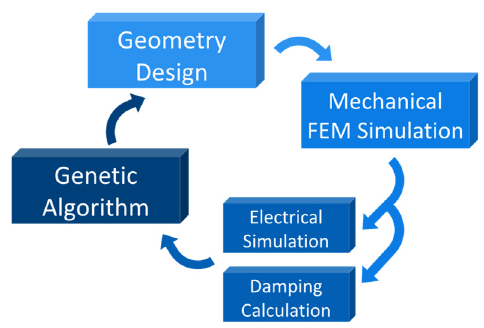
Figure 1. General block diagram for the developed software.